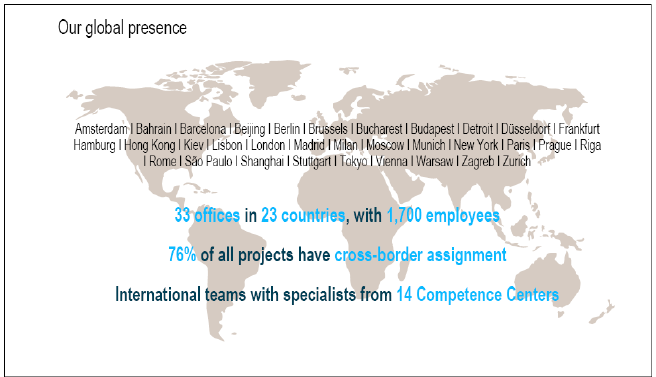
Figure 3 : The Global Presence of Roland